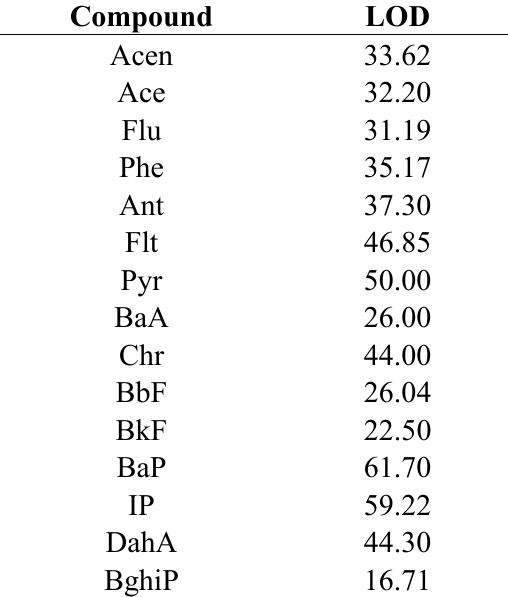
Table 4. Detection limits ng·mL − 1